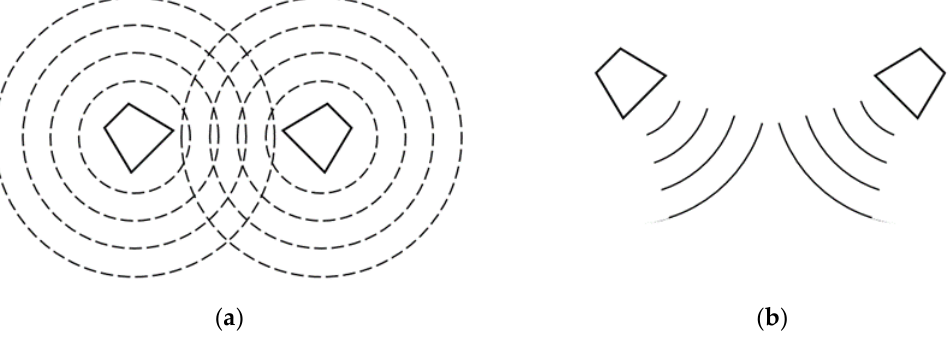
Figure 1. Sweet spot of the stereophonic system.